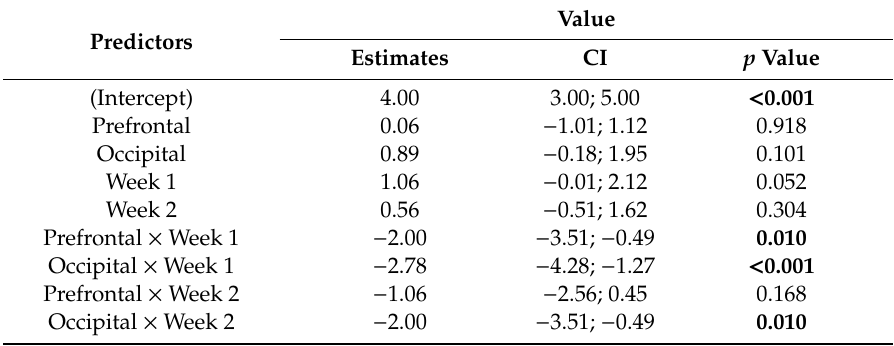
Table 2. Mixed-e ff ect model for the number of migraine days with the ‘patient ID’ being considered as random e ff ect and the interaction between the brain stimulation condition and time as fixed e ff ect.